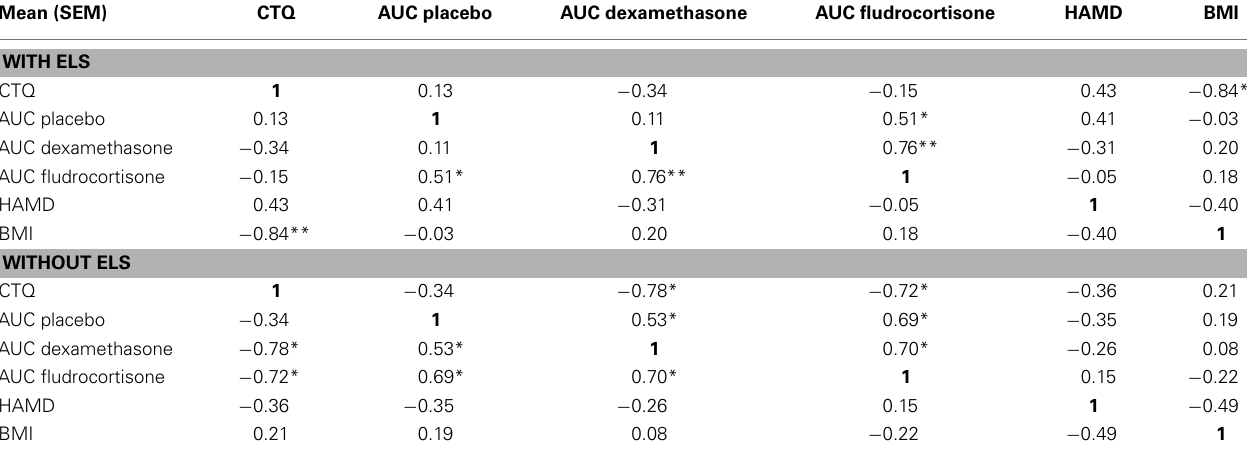
Table 3 | Pearson correlation between CTQ, HAM-D 21 , BMI, cortisol awakening response (measured asAUC) after placebo, dexamethasone and fludrocortisone in a linear regression model in depressive patients with early life stress (ELS) and without ELS